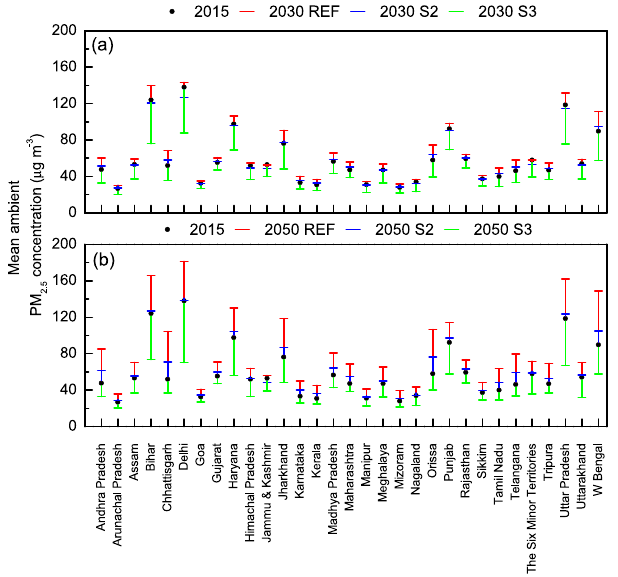
Figure 7. Population-weighted mean ambient PM 2 . 5 concentrations by state for (a) 2015 and 2030 (REF, S2 and S3) and (b) 2015 and 2050 (REF, S2 and S3).